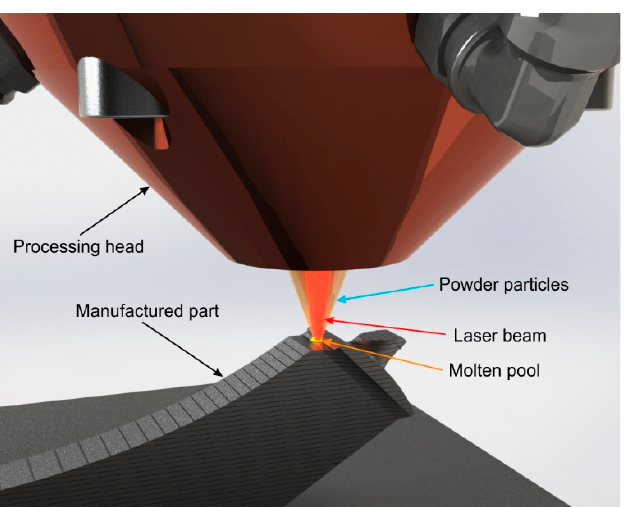
Figure 2. Representative model of the LDED (laser-directed energy deposition) technique with coaxial particle injection setup.